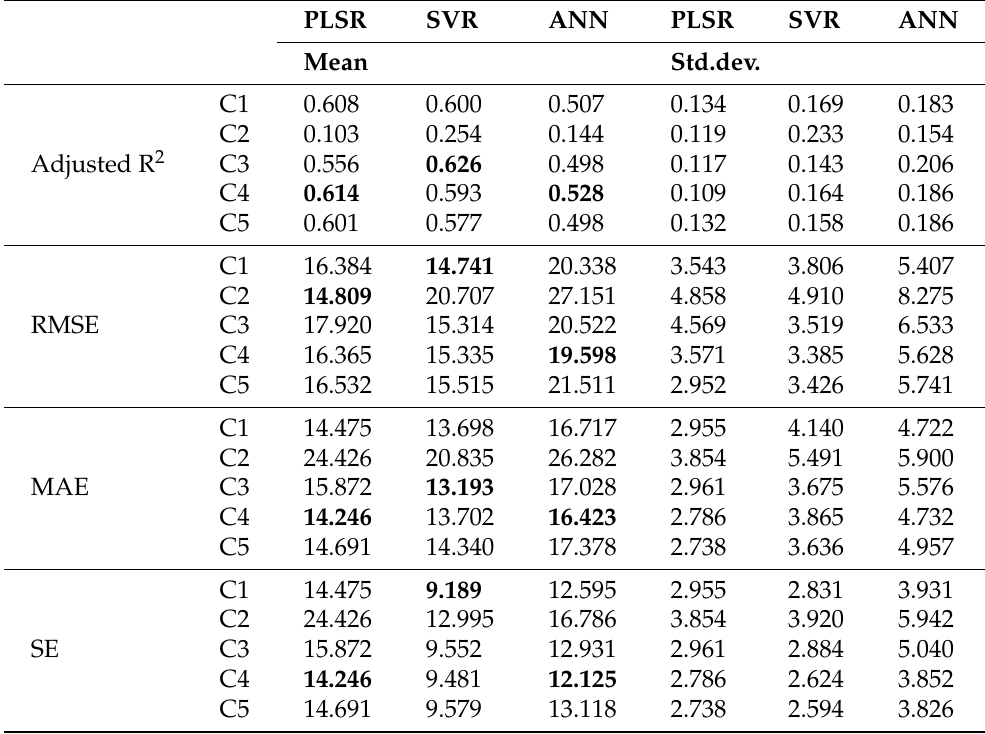
Table 3. Mean and standard deviation of prediction accuracies of Cu concentration estimated by PLSR, SVR and ANN using 20 repeated 6-fold